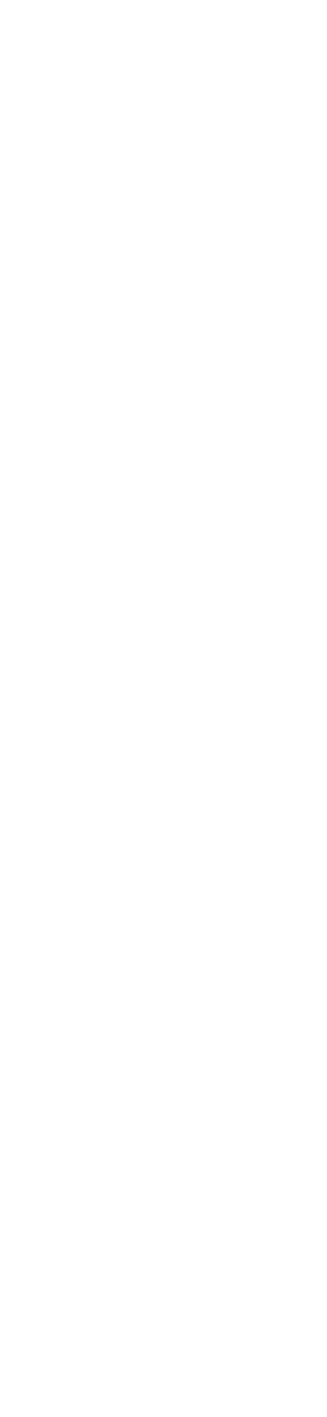
Figure D3. Examples of target (left) and stitched (right) SOI time series for three 20-year windows along the length of the simulation: 2015–2034 in the top four panels, 2035–2054 in the middle four panels, 2081–2100 in the bottom four panels. Results from emulation of SSP2-4.5 and SSP3-7.0 for one of three ensemble members emulated under each scenario for MIROC6.